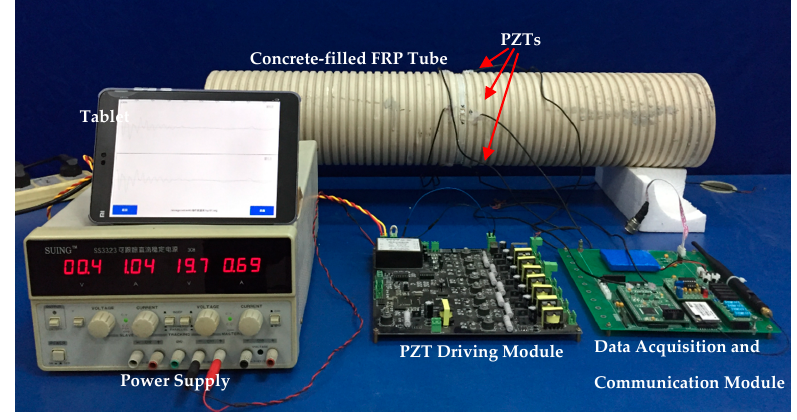
Figure 7. Experimental setup.